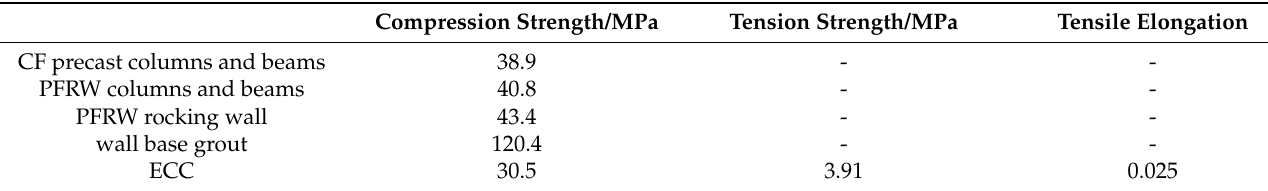
Table 1. Measured cementitious material properties.